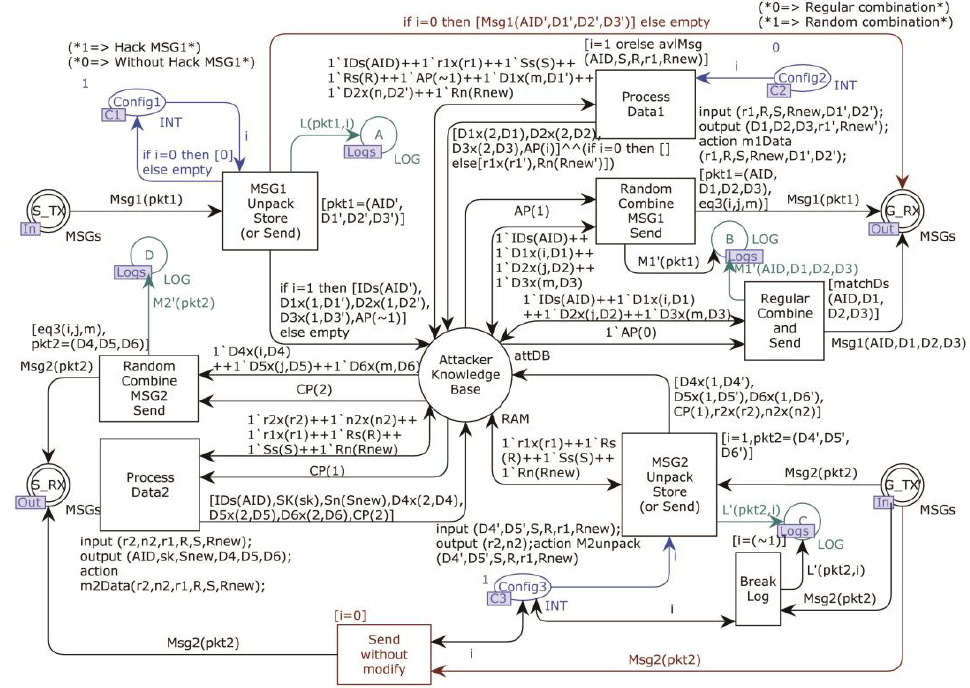
Figure 8. The Attacker model subpage.